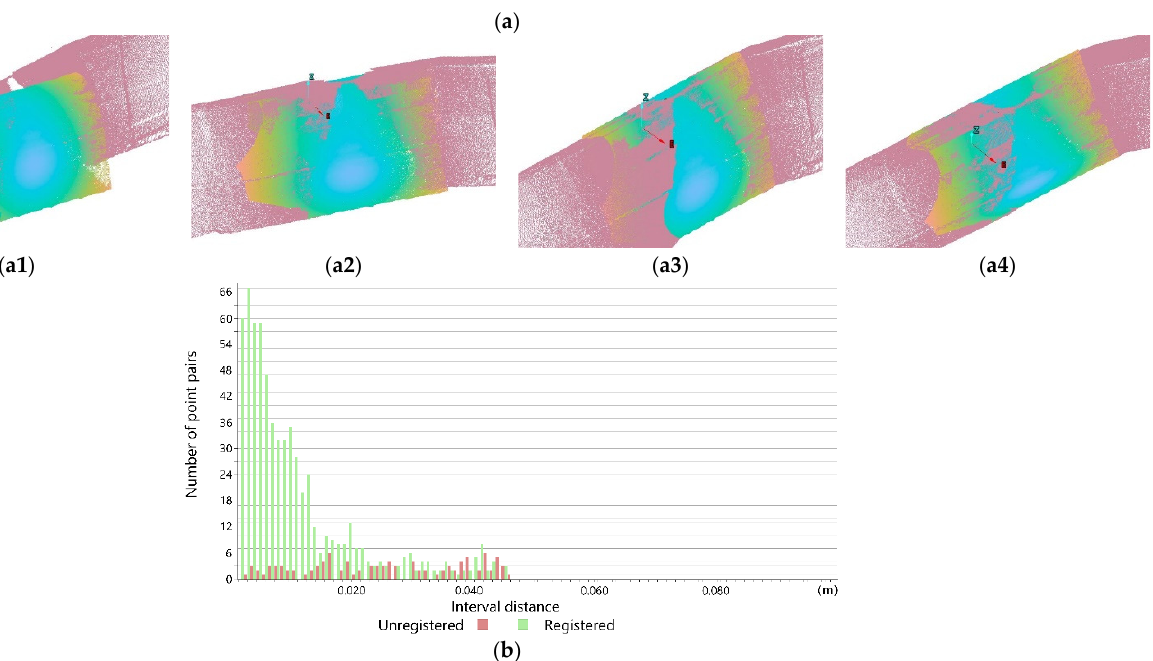
Figure 15. ( a ) Point cloud patching diagram of ISS + ICP algorithm. ( a1 ) Initial pose; ( a2 ) Coarse registration; ( a3 ) Fine registration side view; ( a4 ) Fine registration top view. ( b ) Fine registration verification diagram.